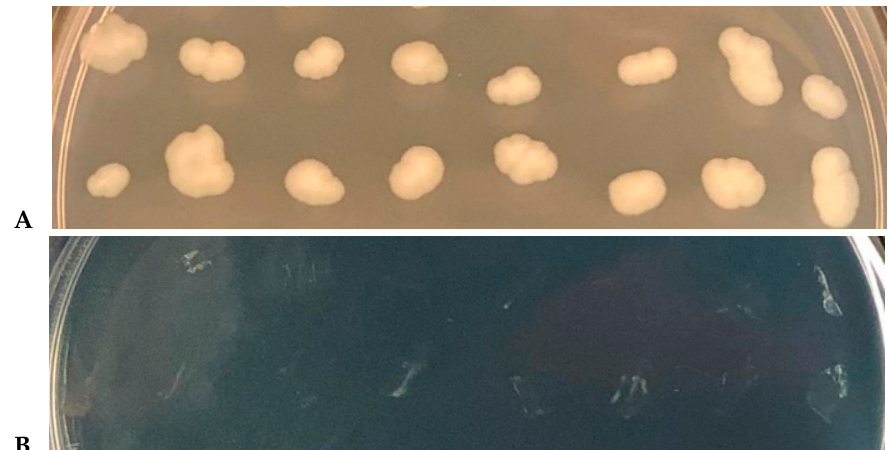
Figure 4. Copper-tolerant mutant strains are unable to withstand 1 × MIC in rich medium. ( A ) Copper tolerant mutants obtained after a 2 h exposition to 160 µg/mL cupric sulfate in NaCl buffer grow normally in LB agar plates after an overnight incubation without copper. ( B ) The same mutants shown in A, but now on a copper-supplemented LB agar plate (1 × MIC, 960 µg/mL). Note that despite being selected for being more tolerant to copper in a short-duration experiment (in NaCl buffer for 2 h), the cells are unable to survive at 1 × MIC when incubated.